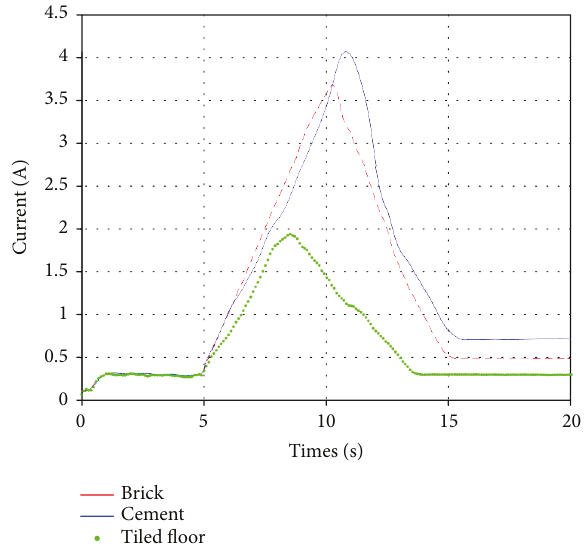
Figure 13: Experimental current tendencies of the four servos on di ff erent terrains.